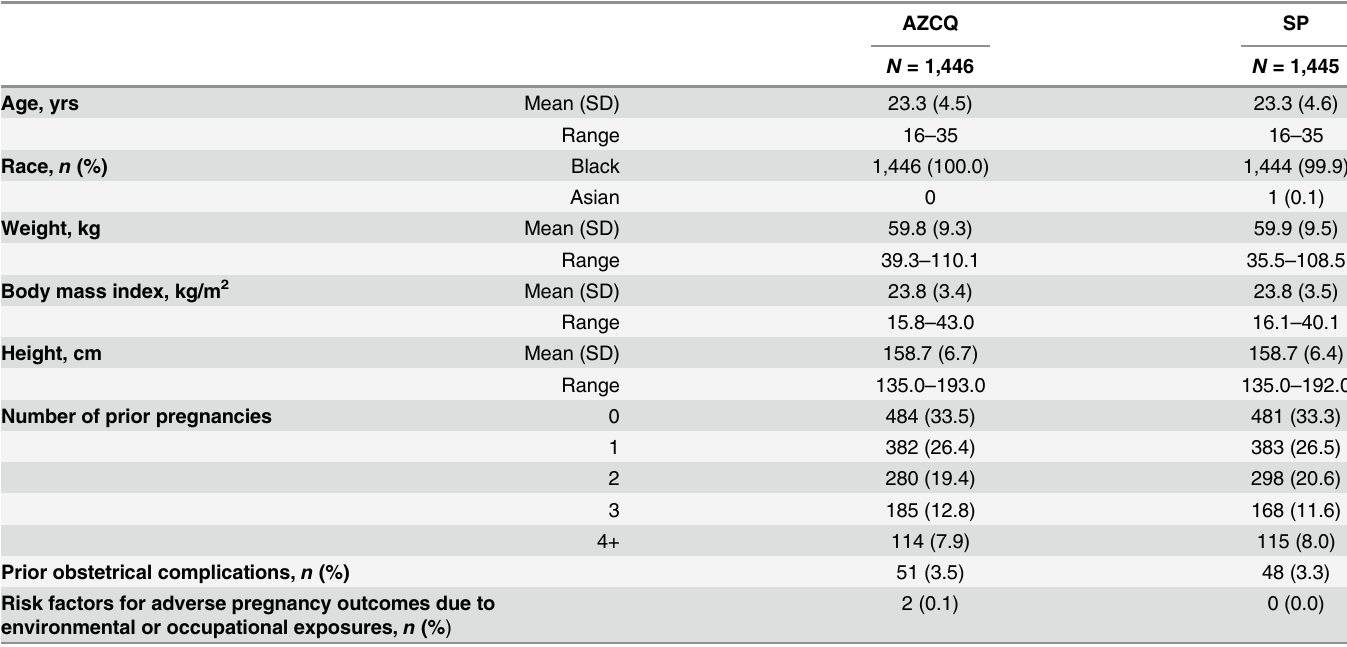
Table 1. Baseline characteristics in the safety